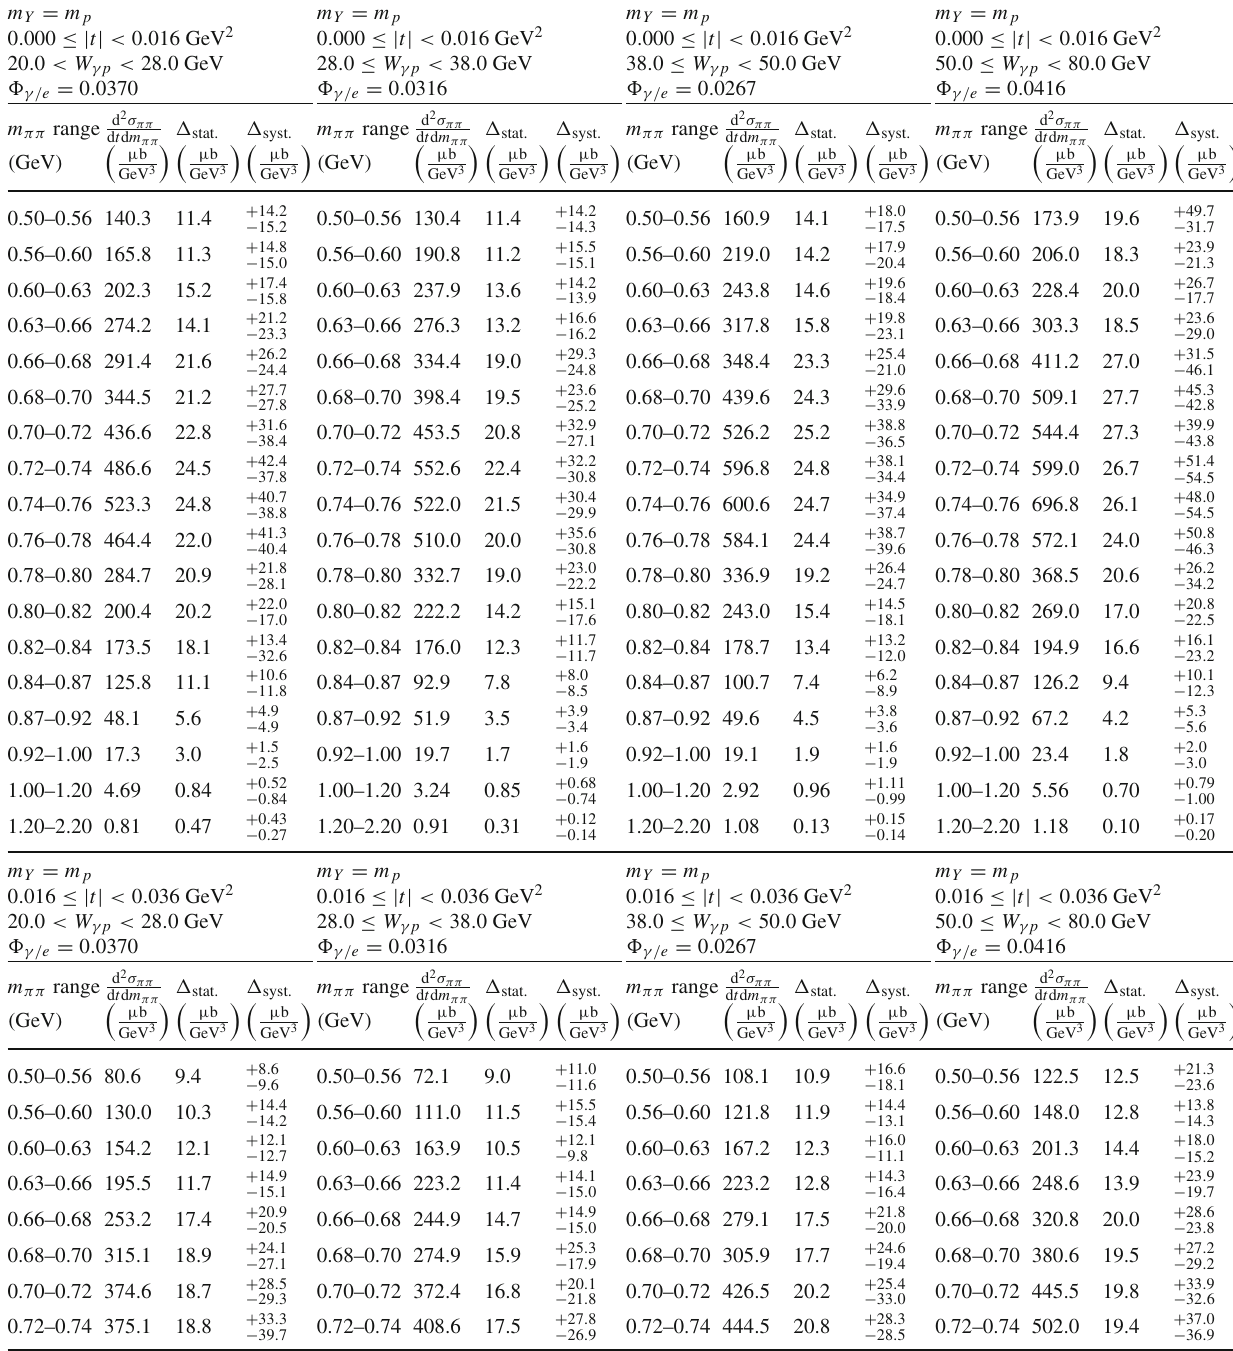
Table22 Unfoldedelastic( m Y = m p )double-differential π + π −